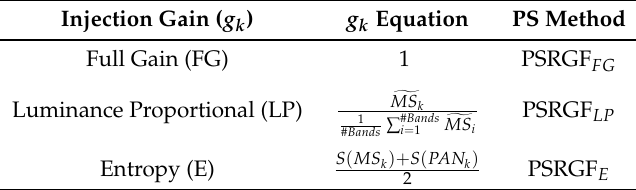
Table 3. Injection gain ( g k ) through an element-by-element multiplication of the spatial details from the PAN to be integrated with the MS image to obtain the PS image and the three names of the corresponding PS